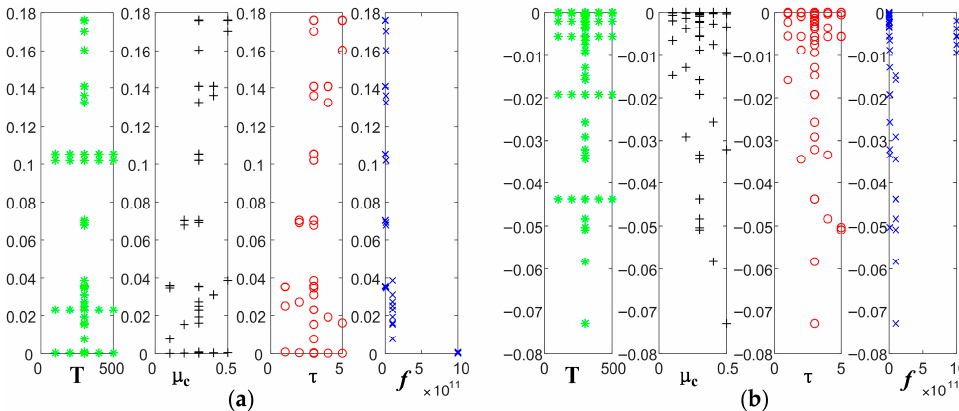
Figure 13. Linear correlation between T, μ c , τ , f , and conductivity: ( a ) real part; ( b ) imaginary part. Next, the four independent variables of temperature, electrochemical potential, re- laxation time, and frequency were used to establish multiple linear regression equations with conductivity, and the regression coefficients corresponding to the four independent variables were calculated using the least-squares method. The real and imaginary regres- sion equations of conductivity are as follows.